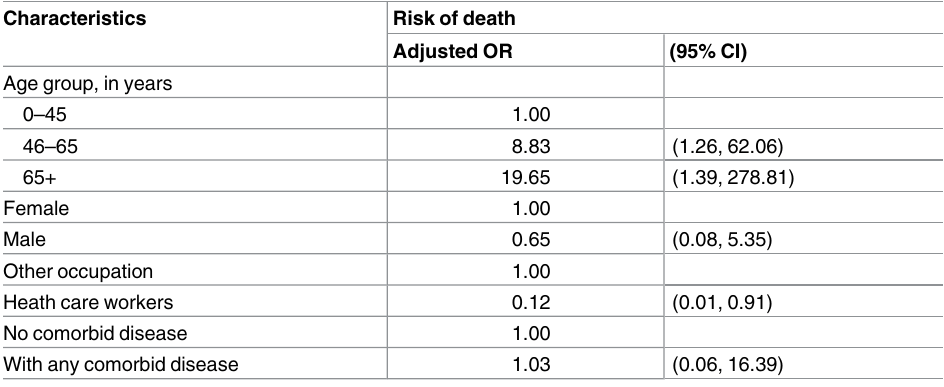
Table 7. Factors associated with fatal outcome in 48 MERS